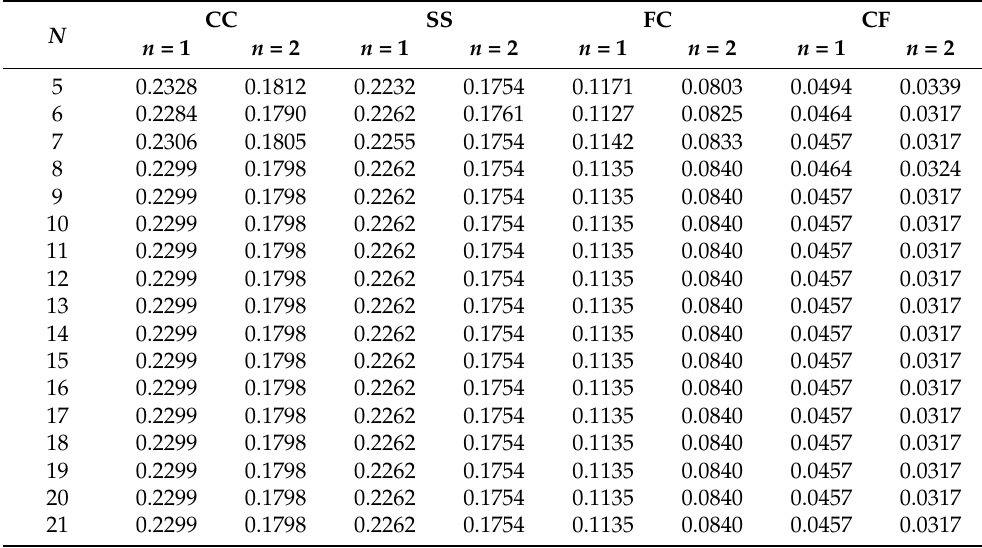
Table 1. Variation of dimensionless frequencies on number of nodes ( m =